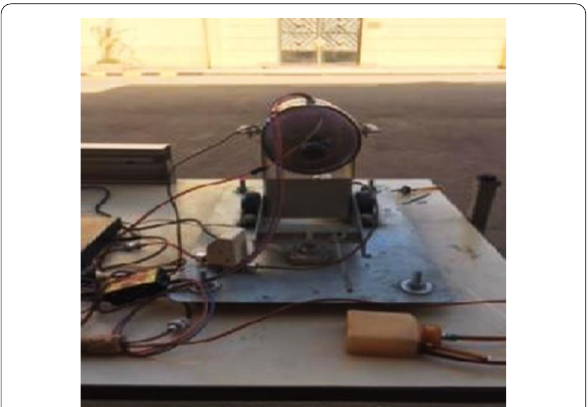
Fig. 4 Jet–Cat 80/120 testing engine